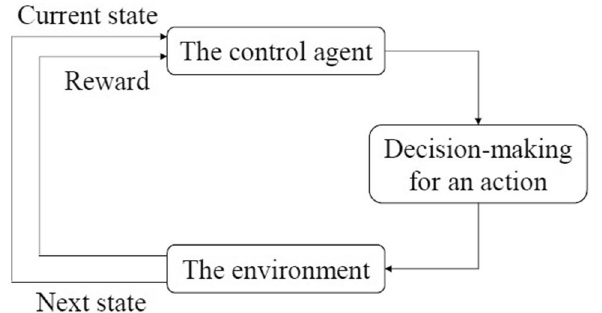
Figure 1. The agent interacts with the environment in a reinforcement learning